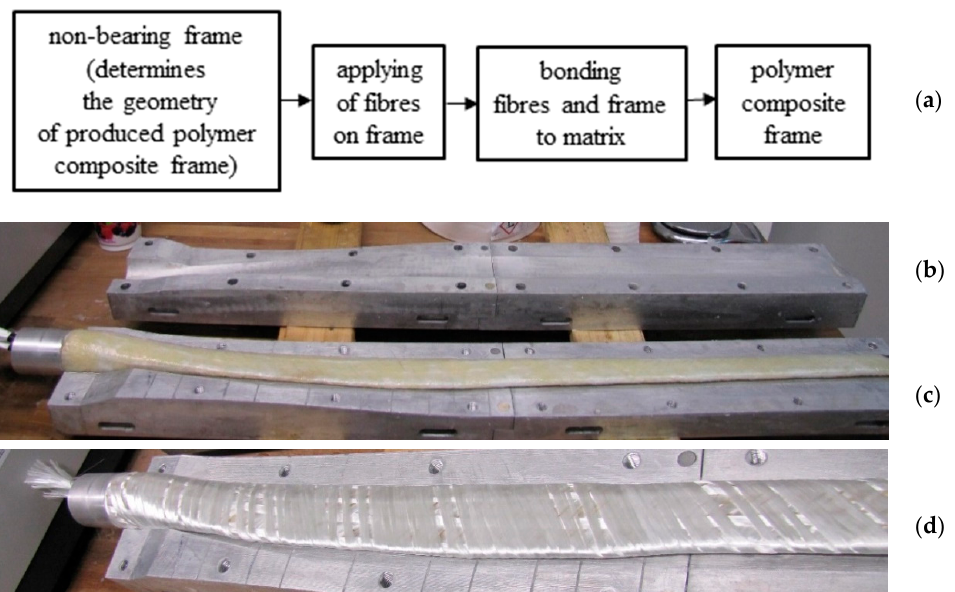
Figure 2. ( a ) production process of long-fiber reinforced polymer composite frame, ( b ) a laboratory mold for holding and curing of the polymer composite frame (example of wind turbine blade), ( c ) the core before fiber winding, and ( d ) wound core with fibers, positioned in the mold before injection of the polymer matrix.